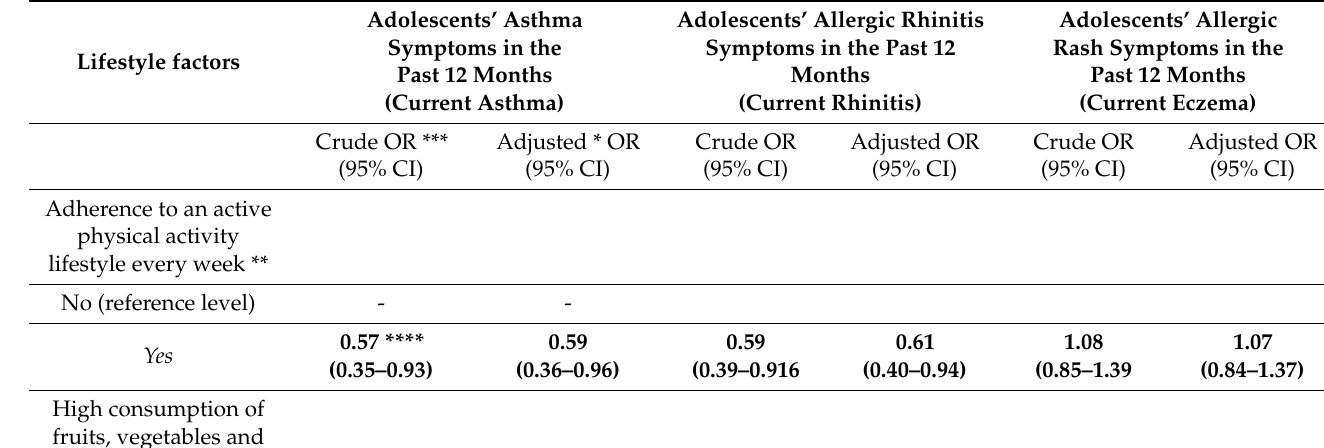
Table 3. Results from the multiple logistic regression analysis assessing the association between history of an atopic disease (asthma, rhinitis, eczema) in the past 12 months and adolescents’ lifestyle factors, adjusted for several confounders * ( n =